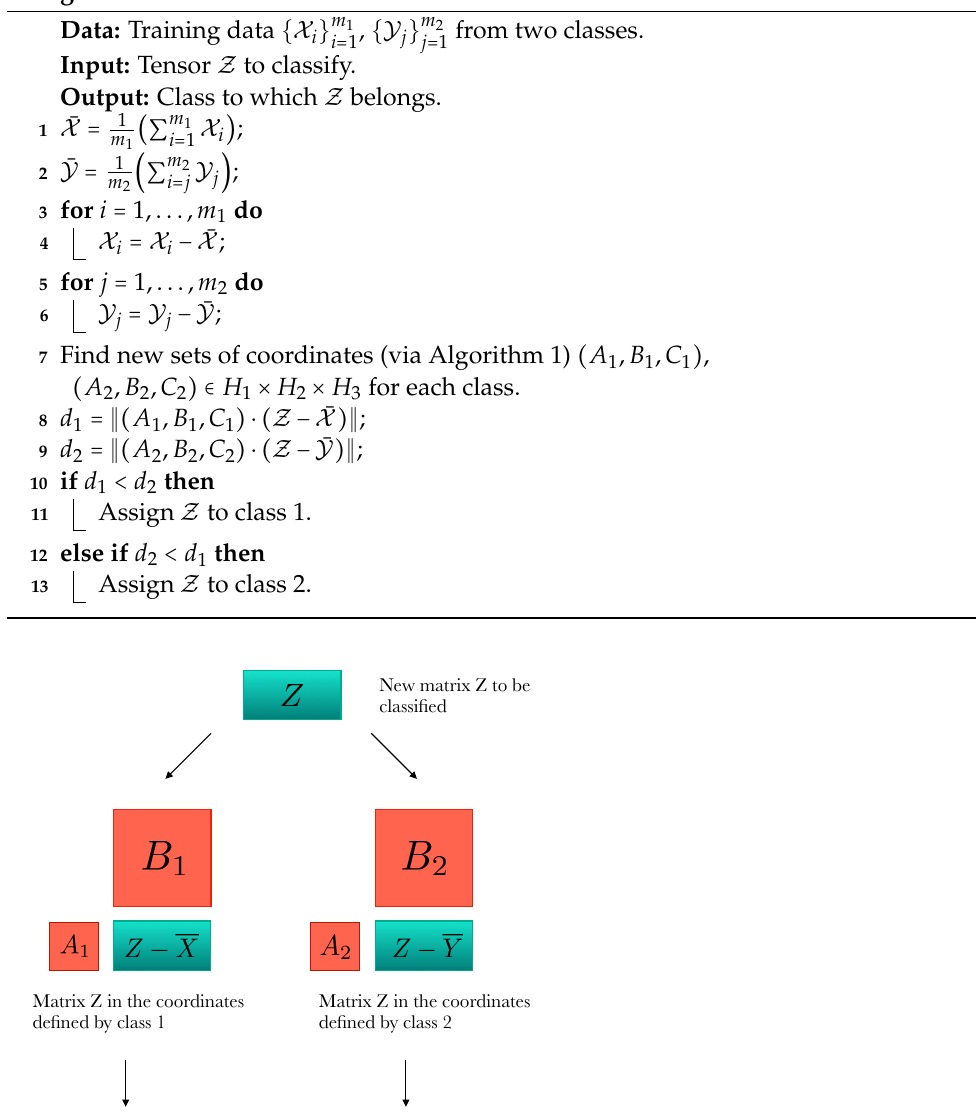
Algorithm 2 Classification via KNMDA.